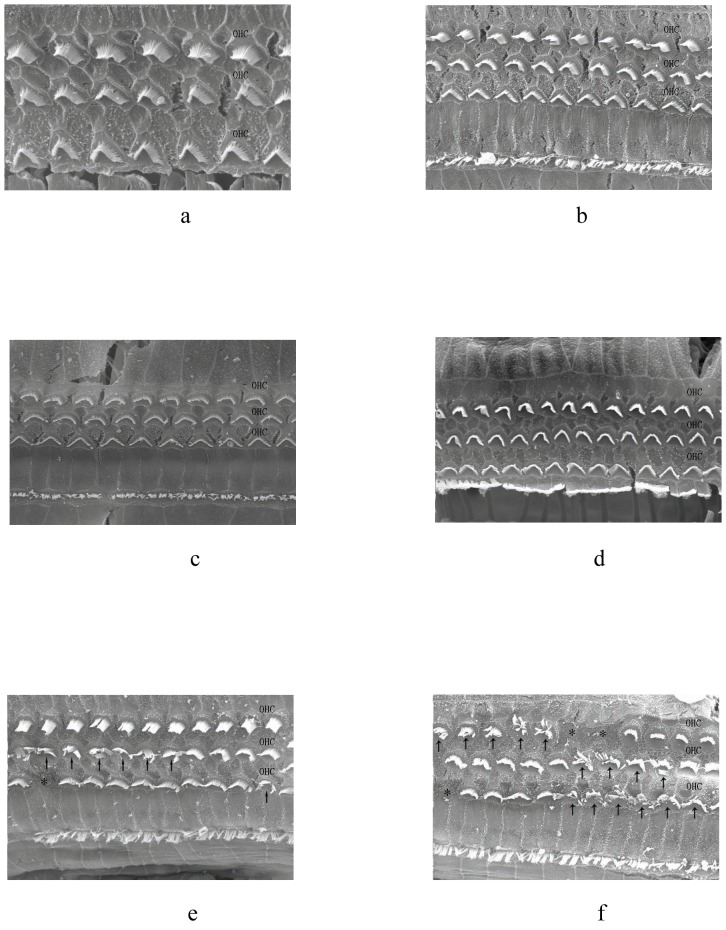
Scanning electron microscopy observations of OHCs.OHCs were well-arranged with normal ciliary structure at three doses of propofol (3a, b, c) and 1.15 vol% isoflurane (3d). Following inhalation of 2.30 vol% isoflurane, certain areas of OHCs were disordered and showed swelling and lodging cilia (3e)(marked by arrows). Following inhalation of 3.45 vol% isoflurane, numerous OHCs had disparate cilia and OHCs were absent in some regions (3f) (marked by asterisk).